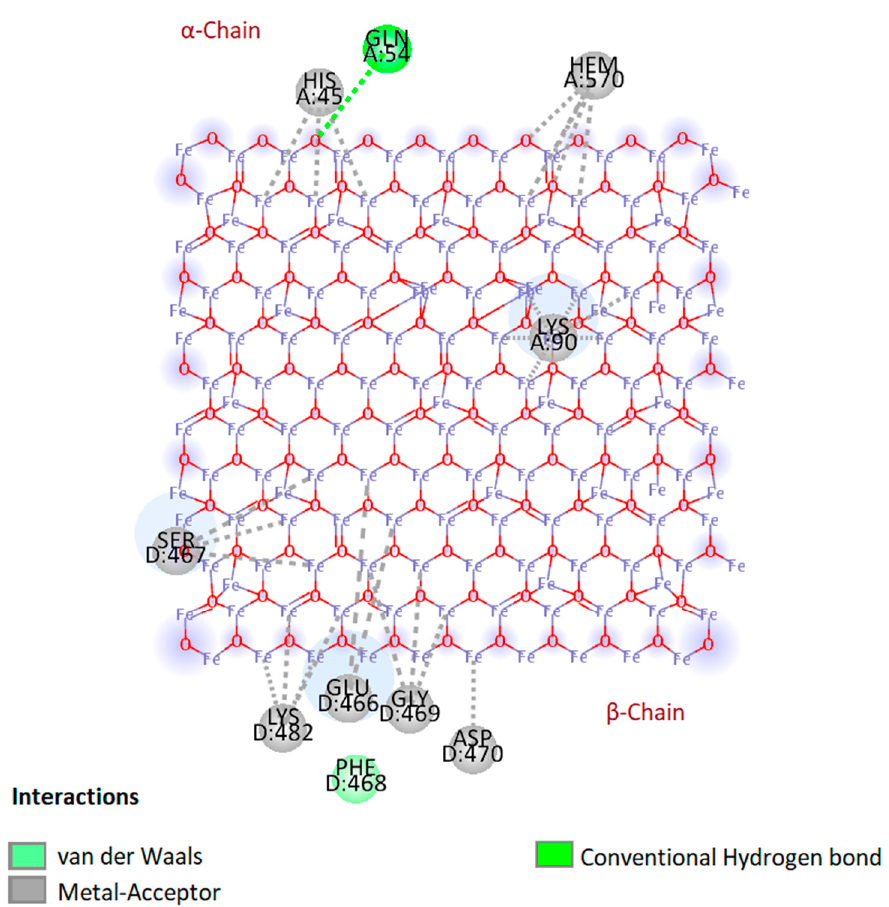
Figure 2. Two-dimensional (2D) diagram showing interactions of hemoglobin HbA1 with bare magnetite nanoparticle slab in the first binding pose.